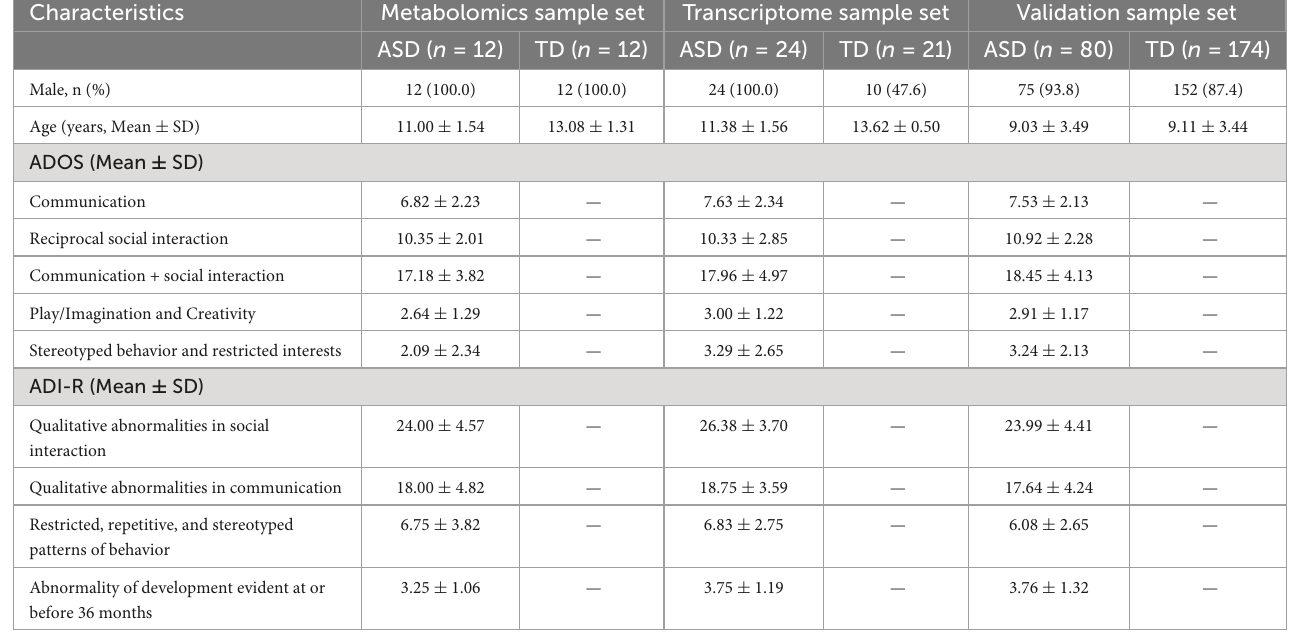
TABLE 1 Demographic characteristics of the study participants.